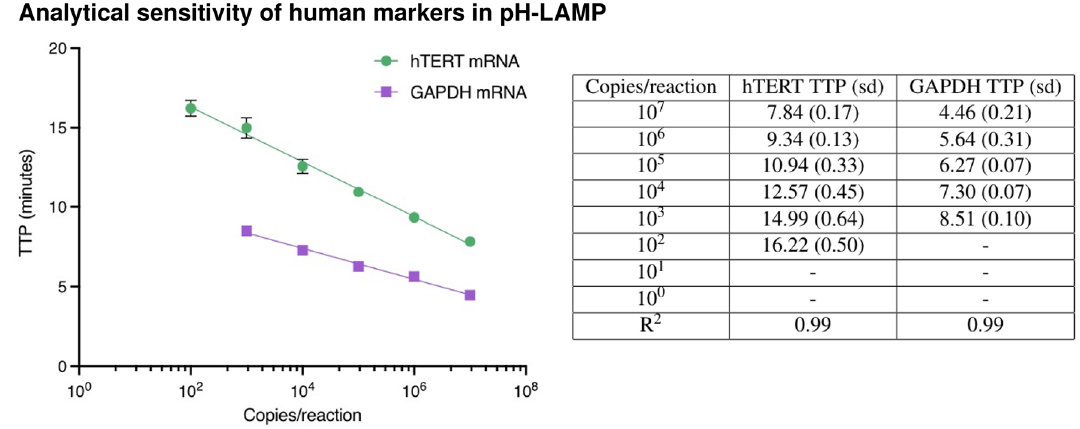
Figure 1. TTP in minutes of serial dilutions of hTERT and GAPDH synthetic mRNA pH-LAMP reaction with respective error bars and